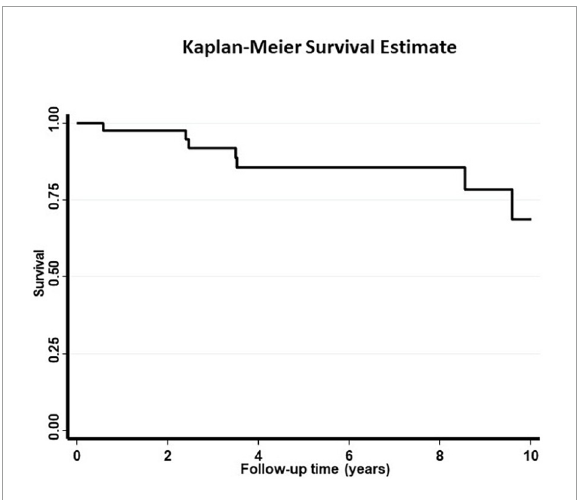
FIGURE2 The 10-year survival curve for 44 patients with cardiac